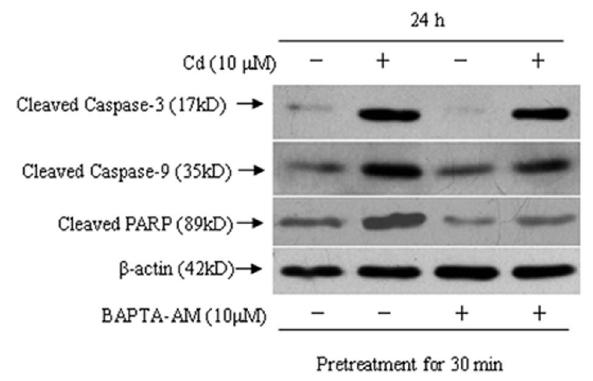
Figure 9. Activation of caspases induced by Cd occurs through calcium signaling. Cells were pretreated with BAPTA-AM (10 m M) for 30 min, followed by treatment with Cd (10 m M) for 24 h. Cell lysates were analyzed by Western blotting. All experiments were performed